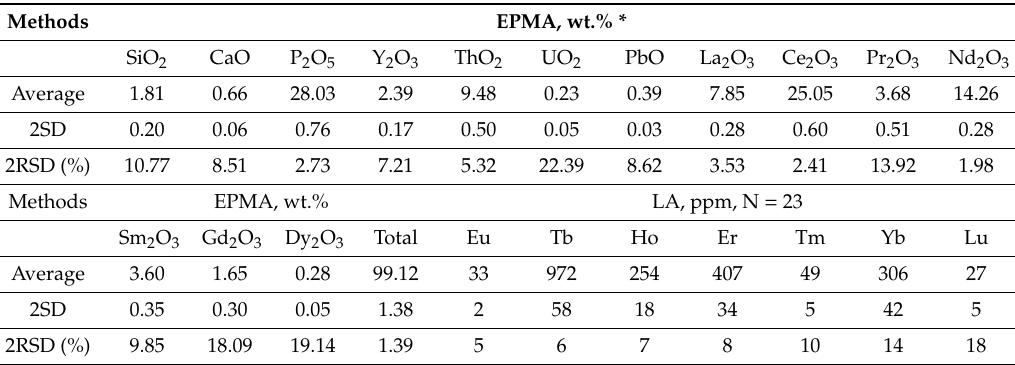
Table 2. Elemental compositions of the RW-1